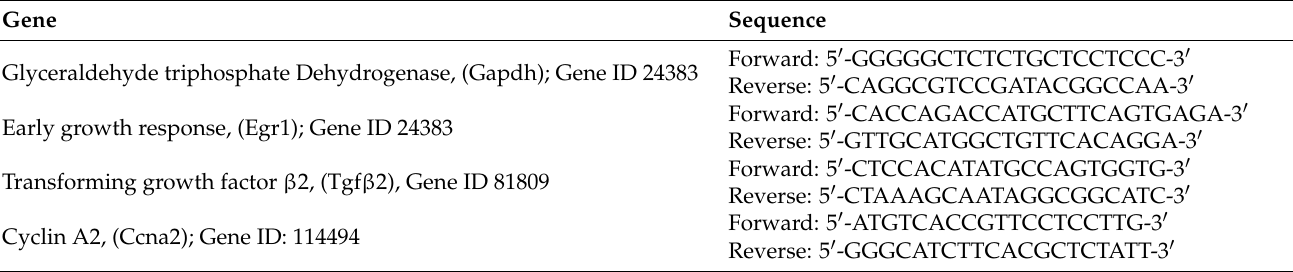
Table 1. Sequence of